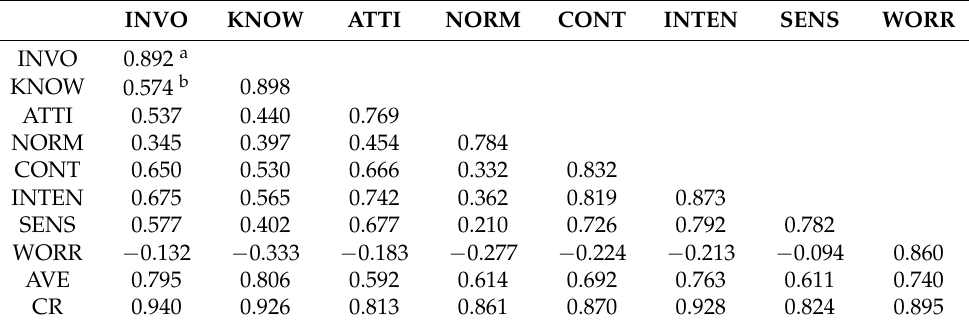
Table 1. Summary of confirmatory factor analysis results. INVO KNOW ATTI